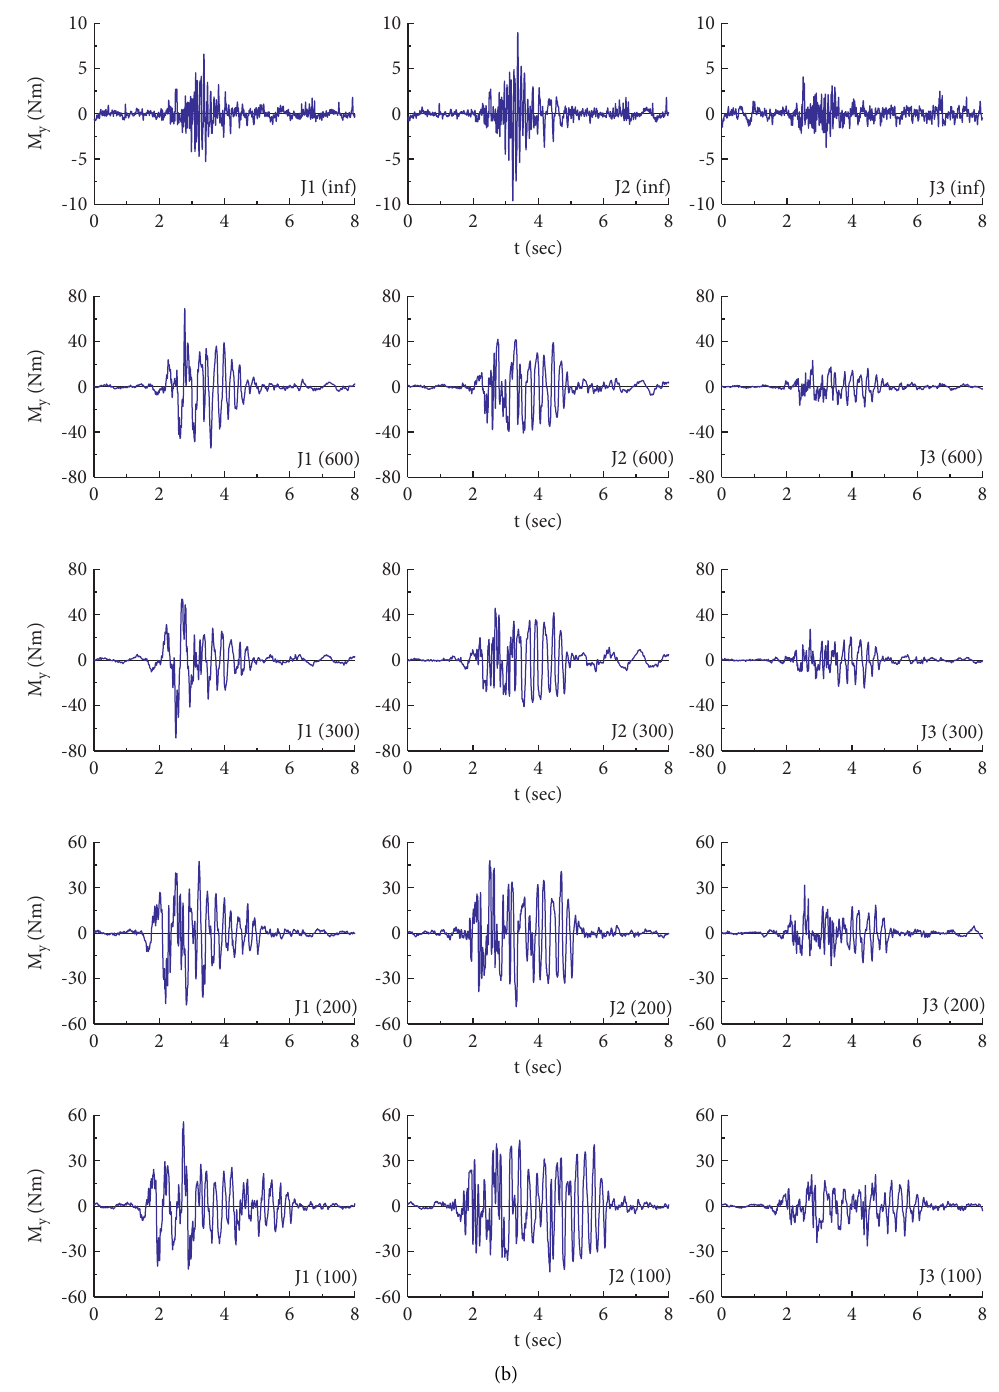
Figure 14: Bending moment of joints. (a) Z direction. (b) Y